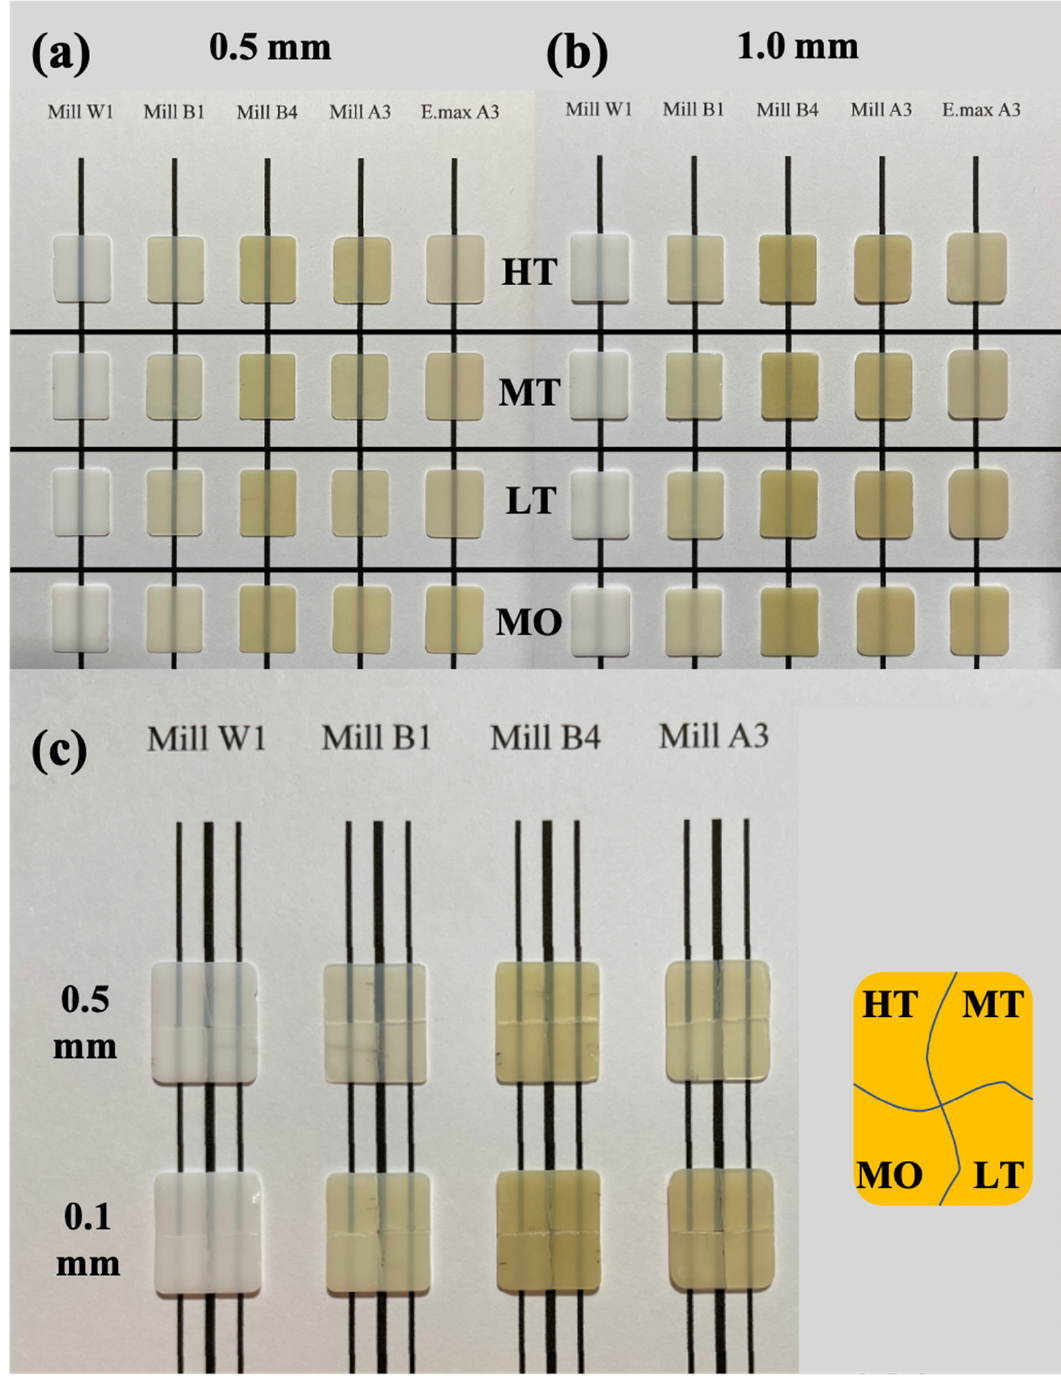
Figure 1. Optical photographs of dental glass-ceramics systems of various sizes, colors, and trans- parencies. ( a ) 0.5 mm and ( b ) 1.0 mm. ( c ) The same block was cut into four samples for sintering at different temperatures (HT 815 °C, MT 825 °C, LT 840 °C, and MO 860 °C).